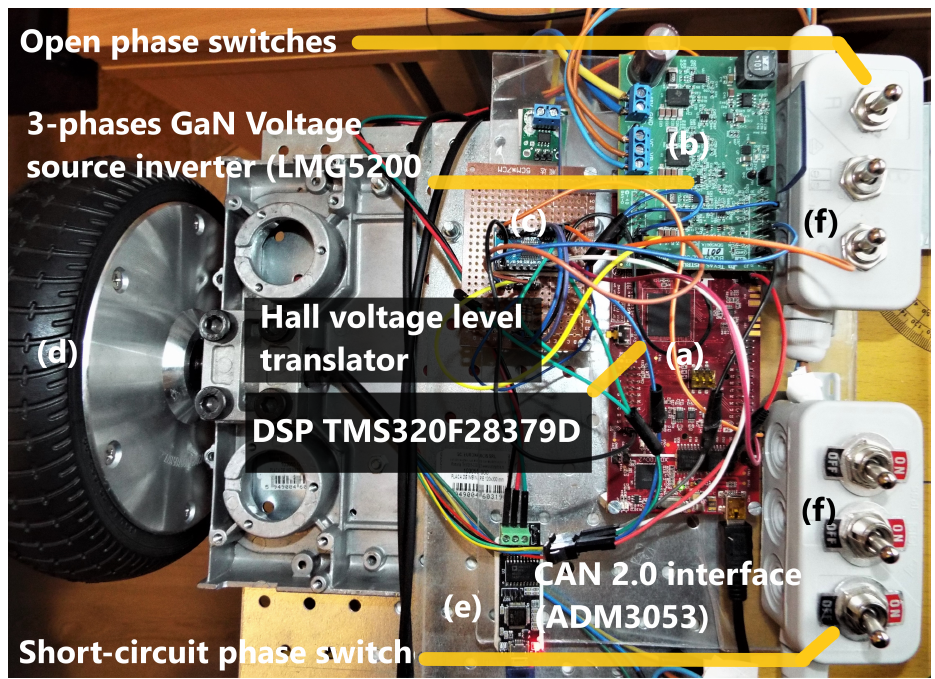
Figure 3. ( a ) DSP control board; ( b ) Three-phase GaN inverter; ( c ) Hall voltage level translator; ( d ) Electrical machine; ( e ) CAN interface; ( f ) Open- and short-circuit stator phase switches. Figure 5 is an image of the GUI used for transmitting and receiving data through the SCI interface. Primarily, the transmitted data are set points and controller parameters, and the received data are the controlled variable. The GUI implements five operating modes for the electrical machine, of which three are used in experiments: inverter OFF , current control , and speed control . The fields param 1... param 4 are used for controller tuning at run time (i.e., dissipating factors and observer coefficients). The currents and speed references are set through the GUI, which further transmits the data via a USB-to-SCI converter to the DSP receiving buffer. The inverter switch seen in Figure 5 is implemented as a measure of protection to prevent damage to the system during tests. The communication speed over SCI was configured at a maximum of 5 Mb/s as can be seen in the GUI image. The block CalcTBPRD calculates the value of the register timer base period (TBPRD) of the ePWM module, setting the frequency of the PWM. The blocks asynchronous rate transitions are buffers used to synchronise data generated and consumed at different